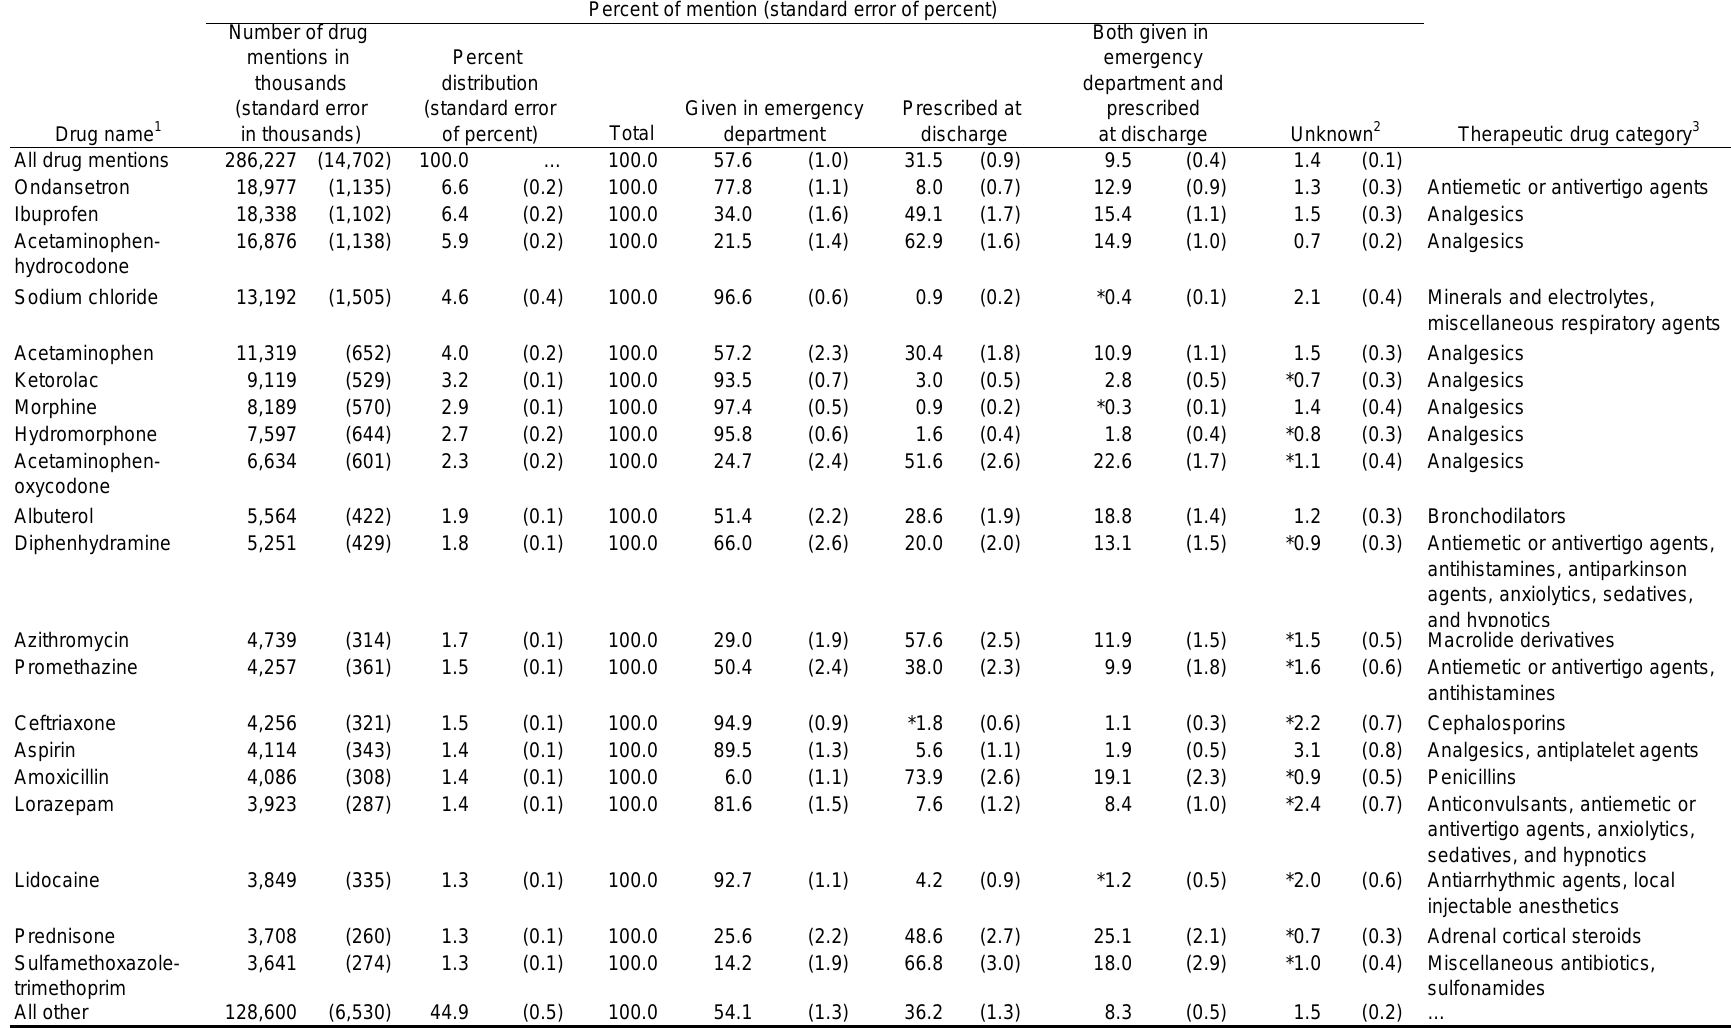
Table 22. Twenty most frequently mentioned drugs at emergency department visits: United States, 2011